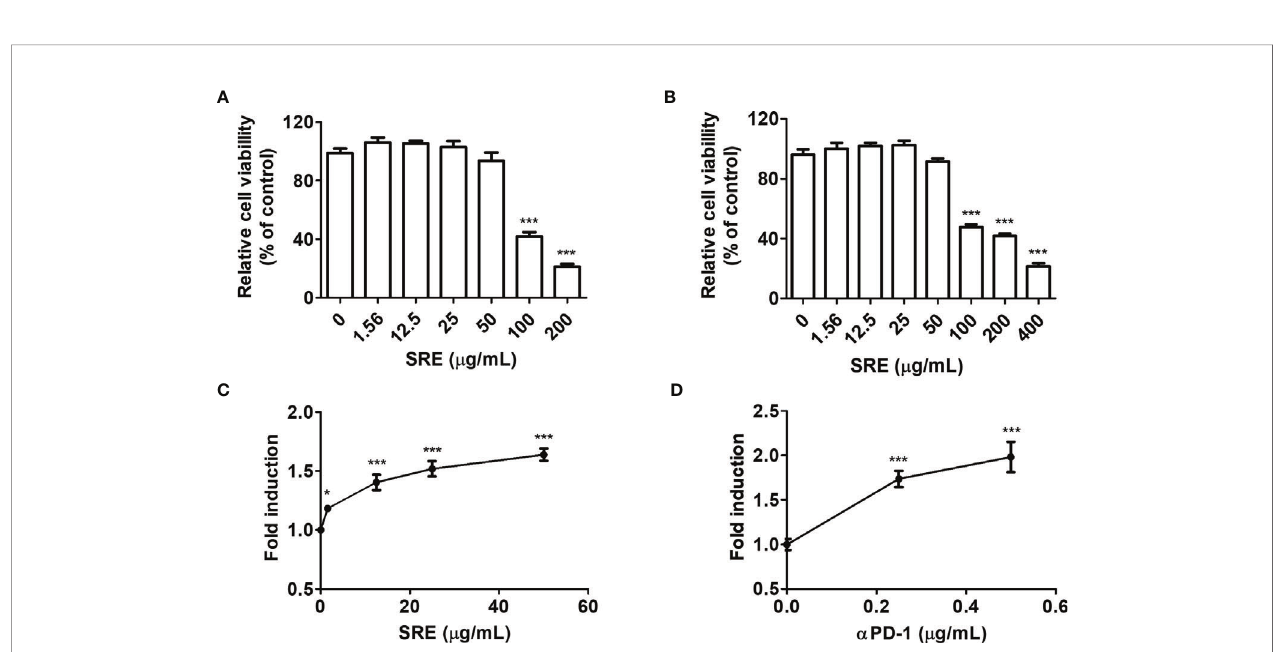
FIGURE 2 | SRE blockade of PD-1/PD-L1 interaction in coculture cell-based luciferase assay. (A, B) Cytotoxicity assay performed using Cell Counting Kit-8 (CCK) assay. The hPD-1/NFAT Jurkat T cells (A) and hPD-L1/TCR CHO-K1 cells (B) after treatment with SRE for 24 hours. (C, D) The PD-1/PD-L1 blockade bioassay was performed using the Bio-Glo ™ luciferase assay system. After addition of hPD-1/NFAT Jurkat T cells and SRE (C) and anti-PD-1 antibodies ( a PD-1) (D) , hPD- L1/TCR CHO-K1 cells were seeded for 20 hours. Data are presented as the mean ± SD. * p < 0.05 and *** p < 0.001 compared to the control.